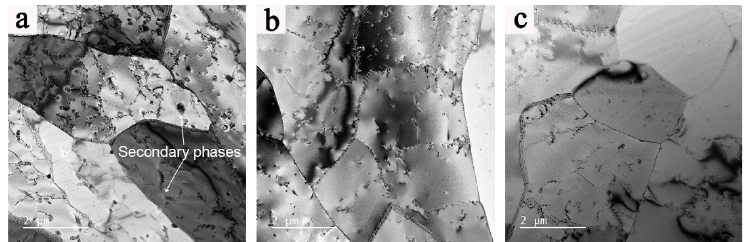
Figure 11. TEM images of the 2198 alloy hot-deformed at di ff erent temperatures: ( a ) 390 °C/0.1 s − 1 , ( b ) 450 °C/0.1 s − 1 , and ( c ) 510 °C/0.1 s − 1 .